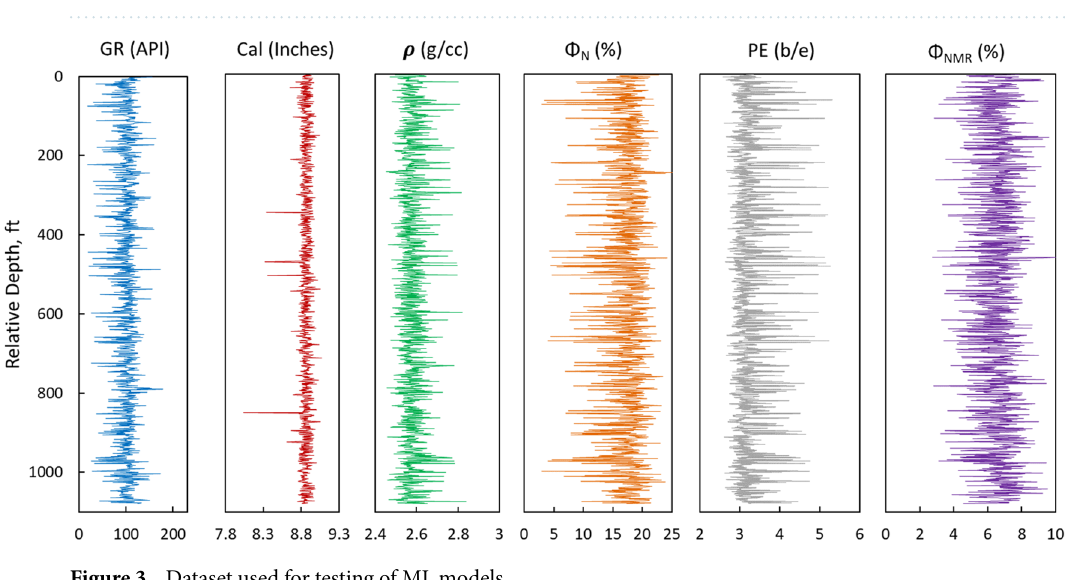
Figure 3. Dataset used for testing of ML